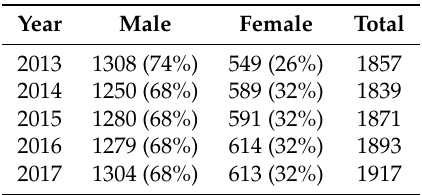
Table 2. Number of male and female suicides among the entire Dutch population in the years 2013 to 2017 (percentage of total in year in